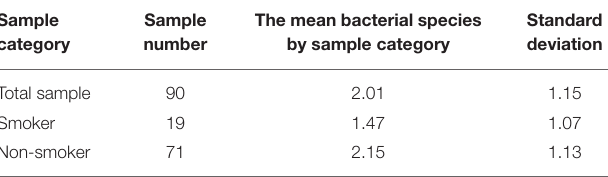
TABLE 1 | Diversity of Gram-positive bacteria cultured in the saliva collected from 90 consecutive disease-free individuals comprised of 19 tobacco smokers and 71